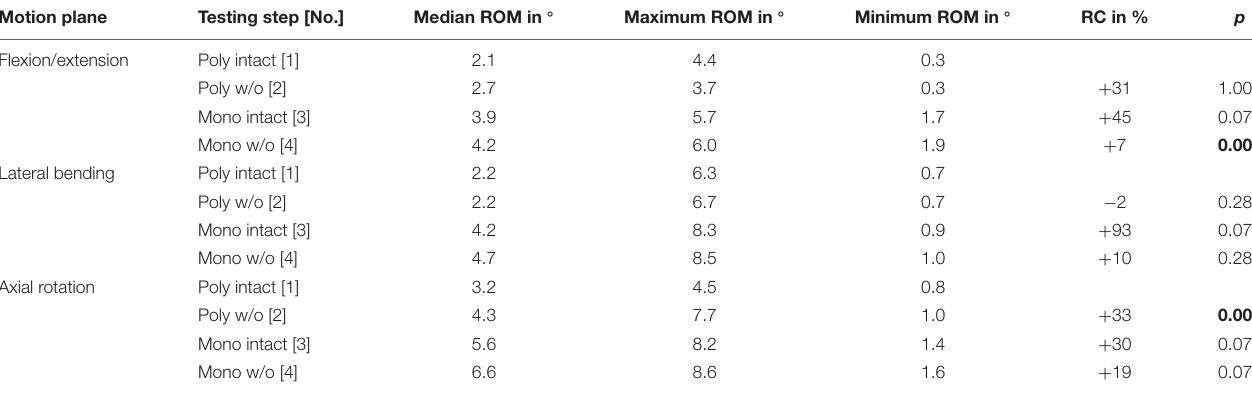
TABLE 7 | Results for T7-T8 range of motion at pure moments of ± 5 Nm ( n = 8) depending on primary motion plane and testing step. Motion plane Testing step [No.] Median ROM in ◦